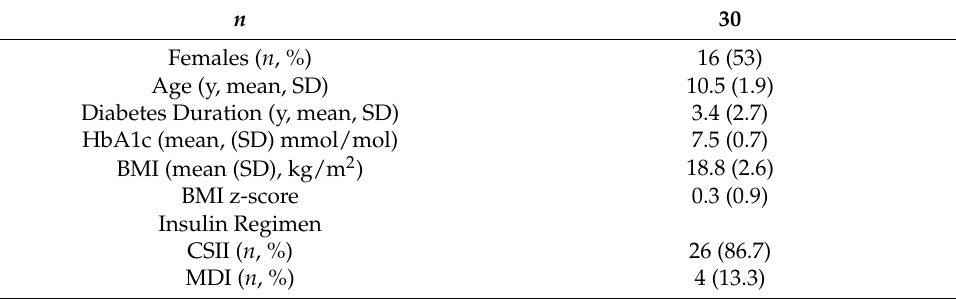
Table 2. Demographic characteristics ( n = 30).